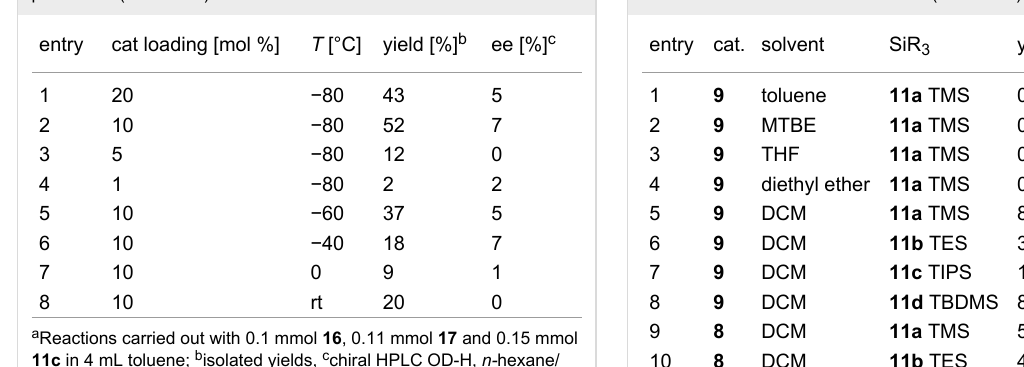
Table 8: Different catalyst loadings of BIFOXSi(OH) 2 ( 9 ) and different temperatures in the N -acyl Mannich reaction of 10 and 11c yielding product 12 (Scheme 6) a .